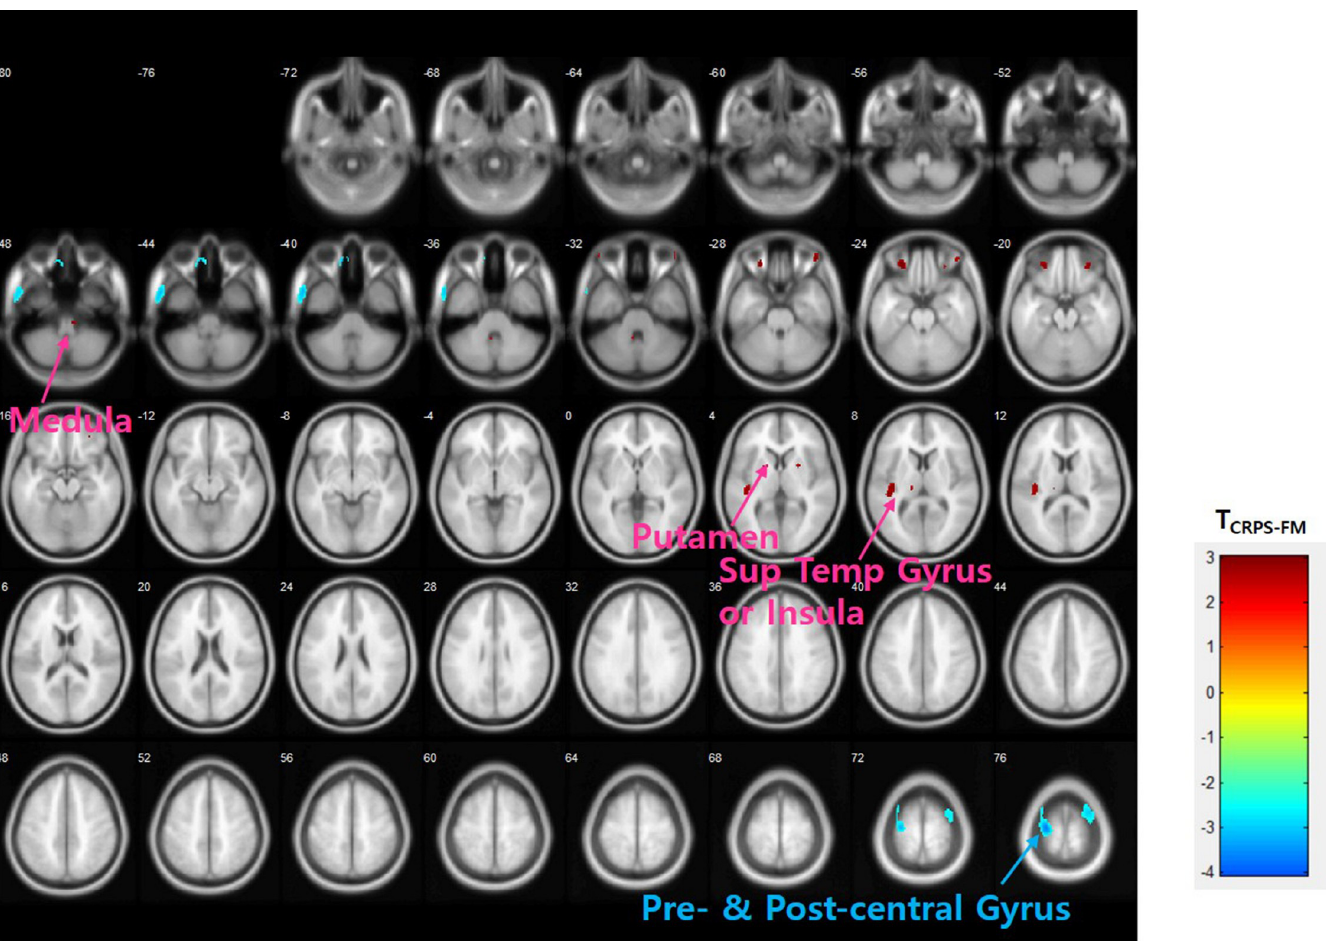
Fig 3. Differences in DVR of [ 11 C]-(R)-PK11195 between FM and CRPS patients. Two sample t-test, uncorrected p < 0.01.